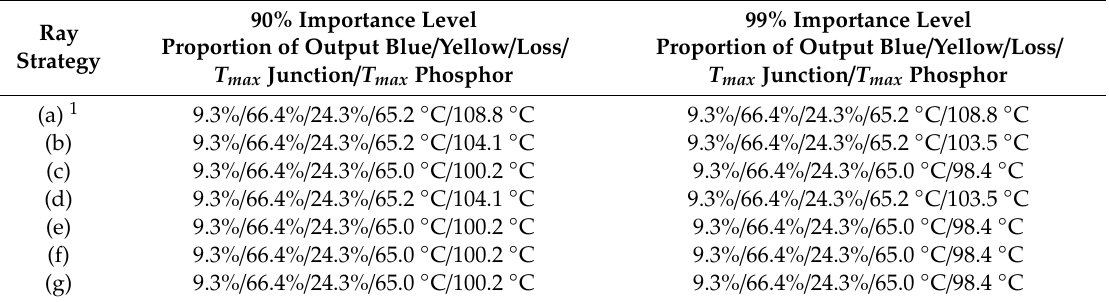
Table 4. Simulation results of the half CoB LED model in the case of 400 mA driving current, no yellow absorption, 90% and 99% importance levels, five blue rays /